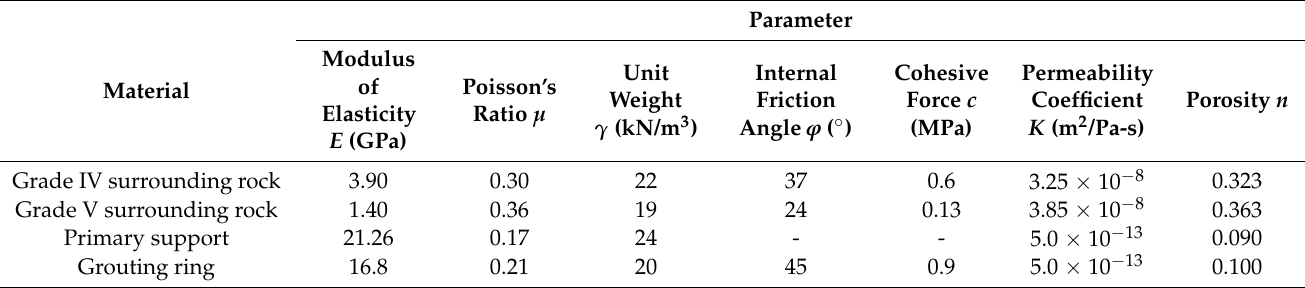
Table 1. Material parameters for the numerical